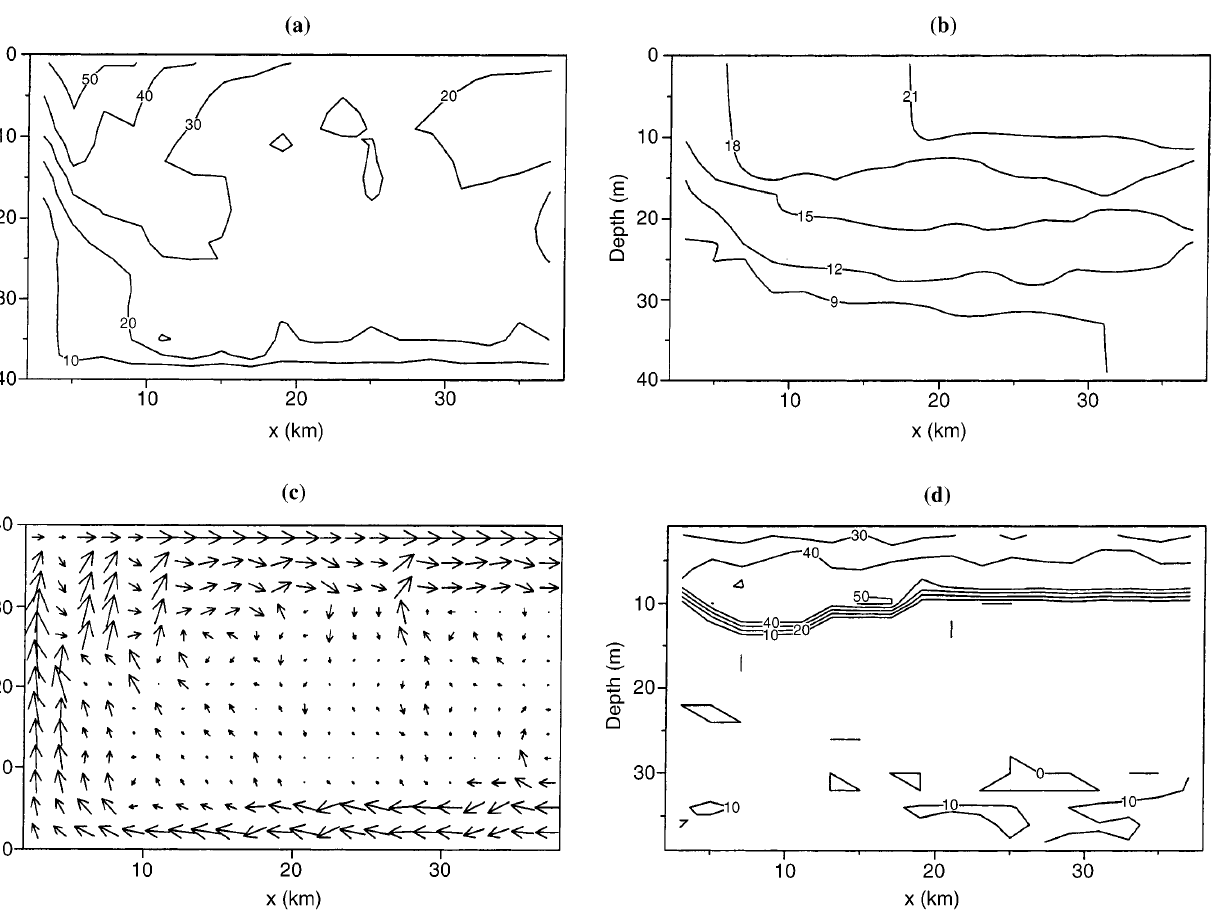
temperature ( (cid:14) C), c vertical current vector ~ U (cid:136) (cid:133) u ; w (cid:2) 10 3 (cid:134) , the maximum length is 14cms (cid:255) 1 , d turbulent viscosity (cid:133) cm 2 (cid:1) s (cid:255) 1